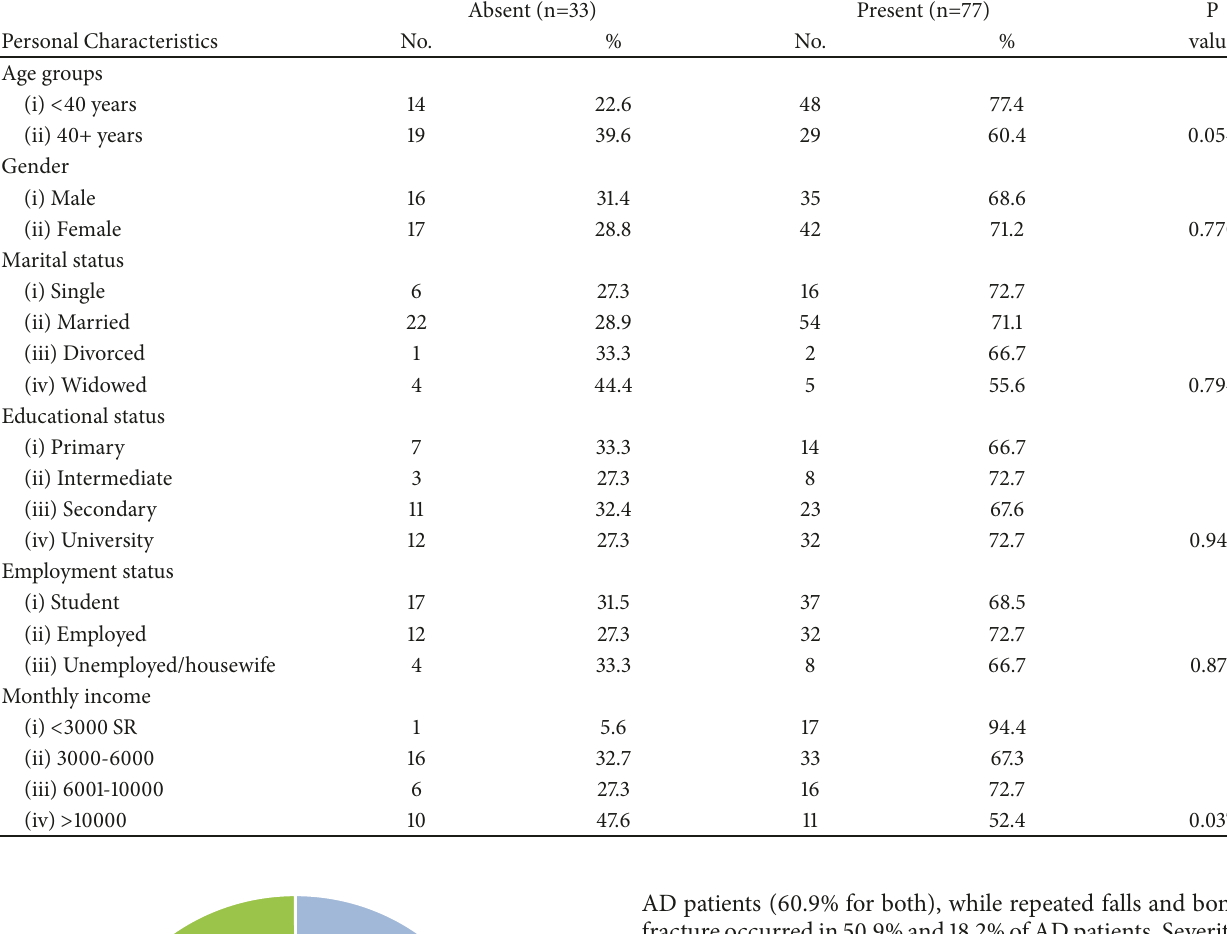
Table 3: Prevalence of depression among caregivers according to their personal characteristics.